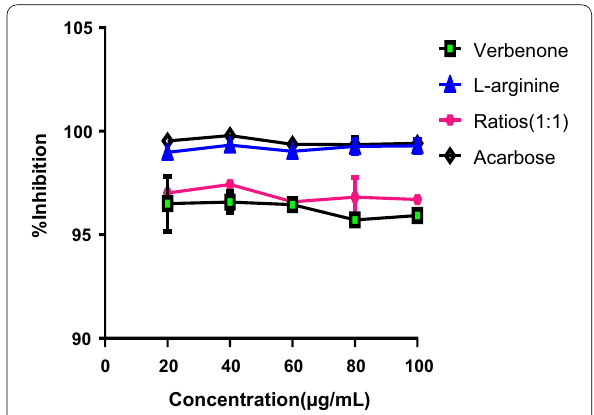
Fig. 2 α-Amylase inhibitory activity of verbenone, L-arginine and ratios of verbenone L-arginine (1:1 v/m). Values are + expressed as mean SEM, triplicated determinations. Ratios ± (1:1) verbenone L-arginine (1:1 v/m) = +